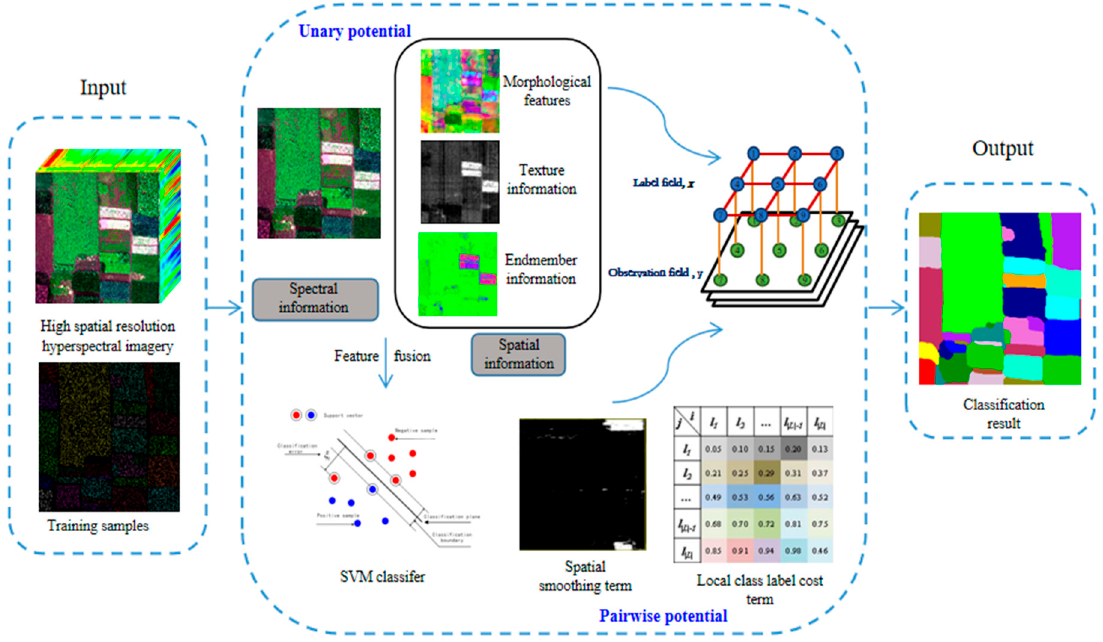
Figure 3. Flowchart of the spectral–spatial fusion based on conditional random fields (SSF-CRF)